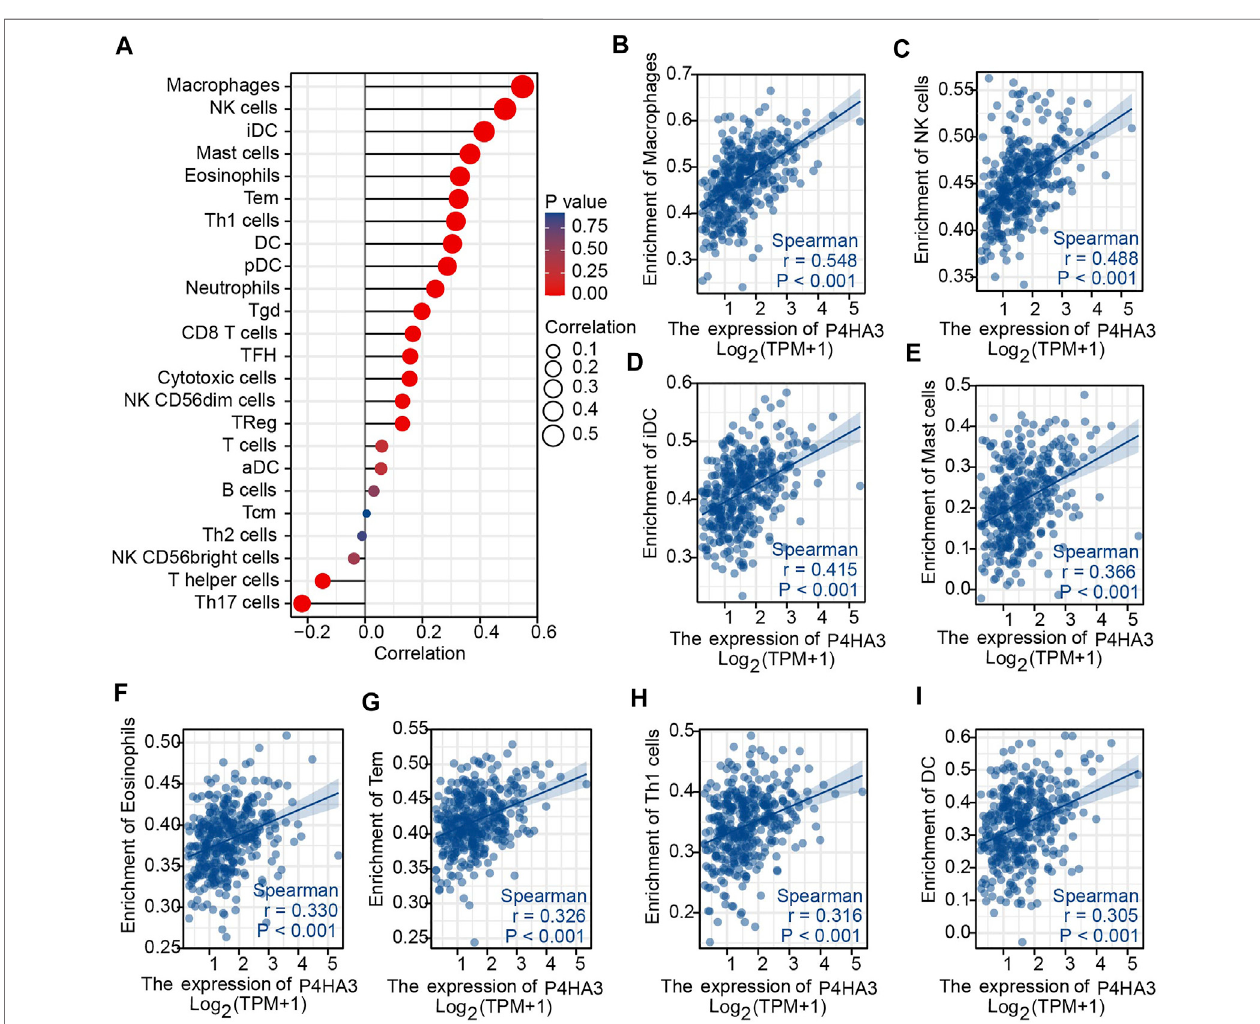
FIGURE 6 | Immune Cell In fi ltration Analysis. (A) The Lollipop Chart shows the correlation between P4HA3 expression level and 24 different immune cell-types; (B – I) theenrichmentscoresofP4HA3expression for8immune cell-types. Abbreviations:NK, natural killer;iDC,immature dendriticcells; Tem, effective memoryTcells; Th1, T-helper 1, DC, dendritic